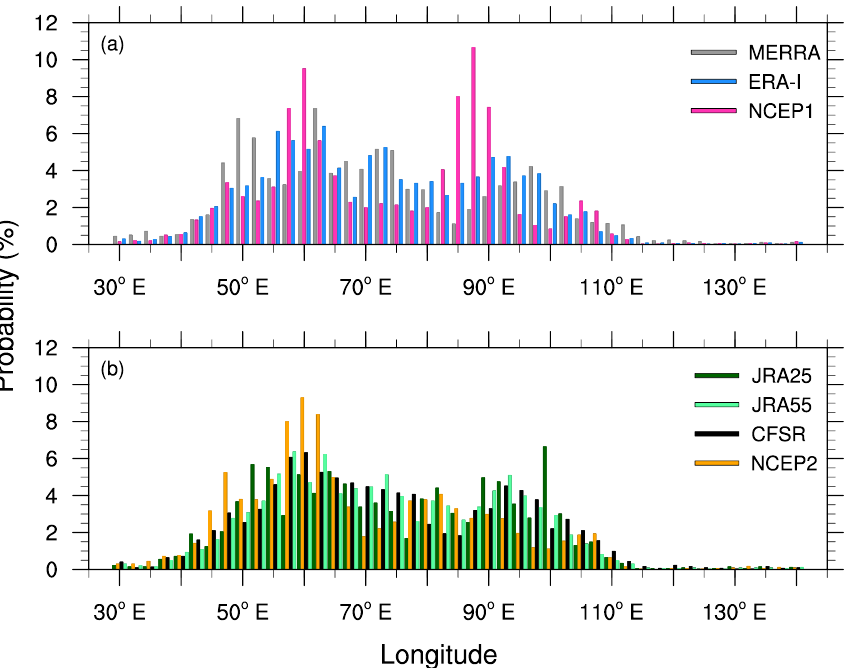
Figure 5. PDF of the daily location of the SAH centre at 100hPa during JJA 1979–2014 (1979–2010 and 1979–2013 for CFSR and JRA-25) for the seven reanalyses. The binning was performed according to the 2.5 ◦ resolution of the data.